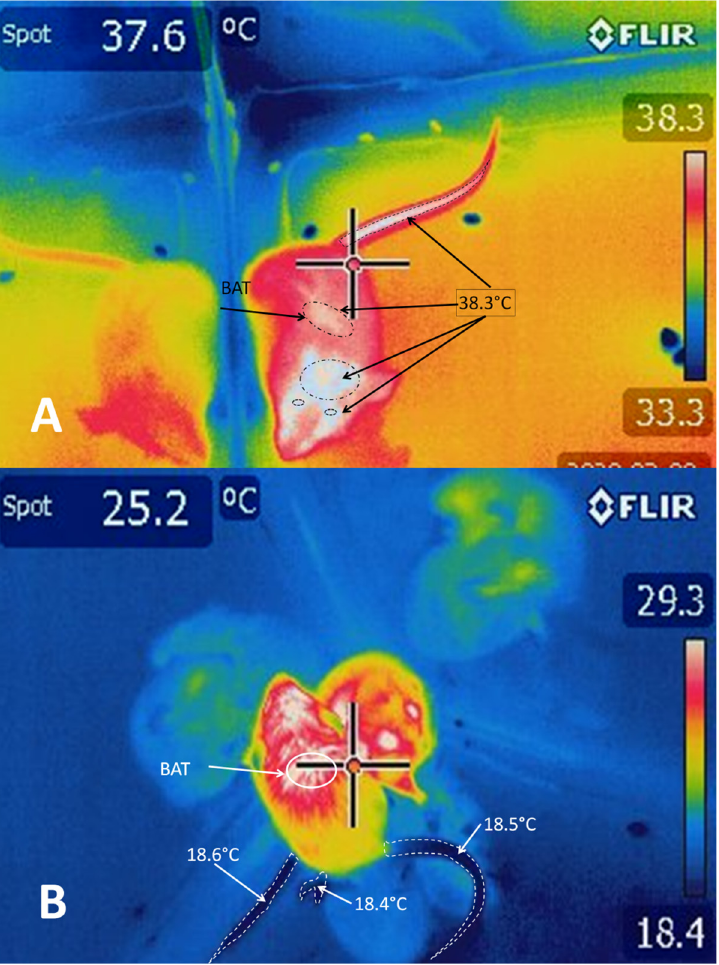
Figure 1. Thermograms of mole-rats subjected to ( A ) heat and ( B ) cold. Clearly, under hot ambient temperatures, the body’s entire surface presents a temperature above 33.3 °C, with a maximum of 38.3 °C on the face, back, and tail. In contrast, in a cold environment ( B ), the tail and pelvic limbs present a surface temperature of 18.4–18.6 °C, with a maximum of 29.3 °C in the head, eyes, and back. Observations show that heat distribution differs depending on the stimulus. In warmer environments, the zones with greater heat are the eyes, head, back (the prescapular zone where brown adipose tissue (BAT) is stored), and tail; while under cold conditions, heat concentrates in the eyes, head, and the first part of the back. Thermogram A shows the mechanism of peripheral cutaneous vasodilation under high temperatures, which increases heat transfer towards the environment, while thermogram B illustrates the mechanism of peripheral cutaneous vasoconstriction, visible on the pedal surfaces and tail, at low temperatures. This mechanism conserves heat in the organism’s core region to protect its vital organs [54]. The images also show that the tail and feet are key organs for conserving and dissipating heat in two thermally distinct environments. These findings agree with McGowan et al.’s report on mole-rats [53]. The animals shown in the thermograms were subjected to ambient temperature changes for only 30 min, following Mexican regulations for the care and use of experimental animals. (Images obtained with an FLIR E 50 camera equipped with an 18-mm FOL lens at a resolution of 240 × 180 pixels, (emissivity = 0.95, distance = 0.5 m)). The detection of heat changes is performed by nerve endings with transient receptor potential (TRP), specifically, type 8 [55,56], functioning as cation channels. Typical physio- logical responses to cold environments include shivering and cutaneous vasoconstriction (CVC), which prevent heat loss and generate heat. In contrast, under high temperatures, the primary somatosensory neurons in the skin are activated by type-2 TRP